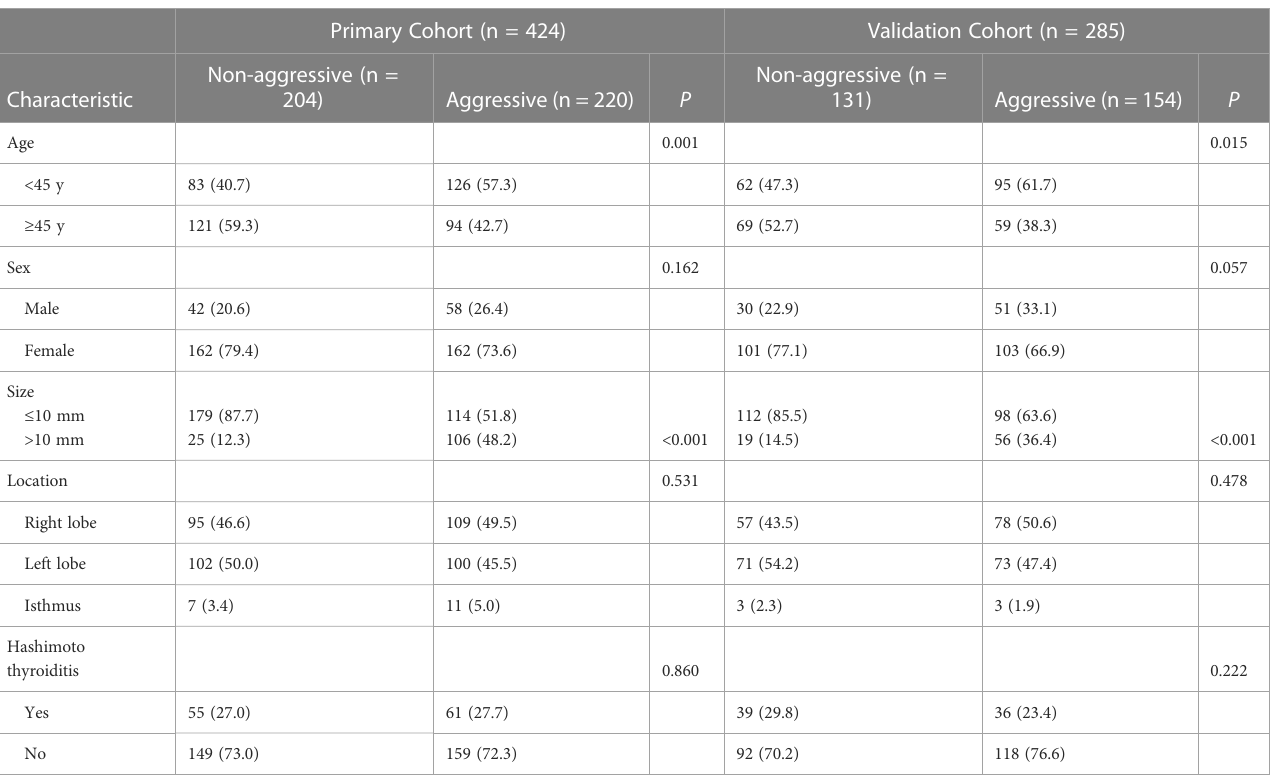
TABLE 1 Baseline characteristics of patients in primary and validation cohorts. Primary Cohort (n =